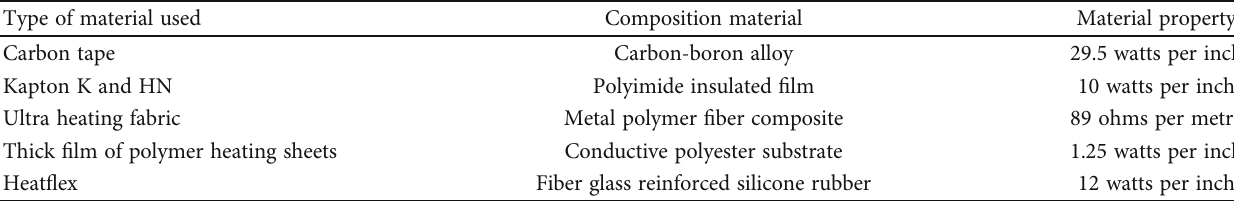
Table 1: Properties of the material.